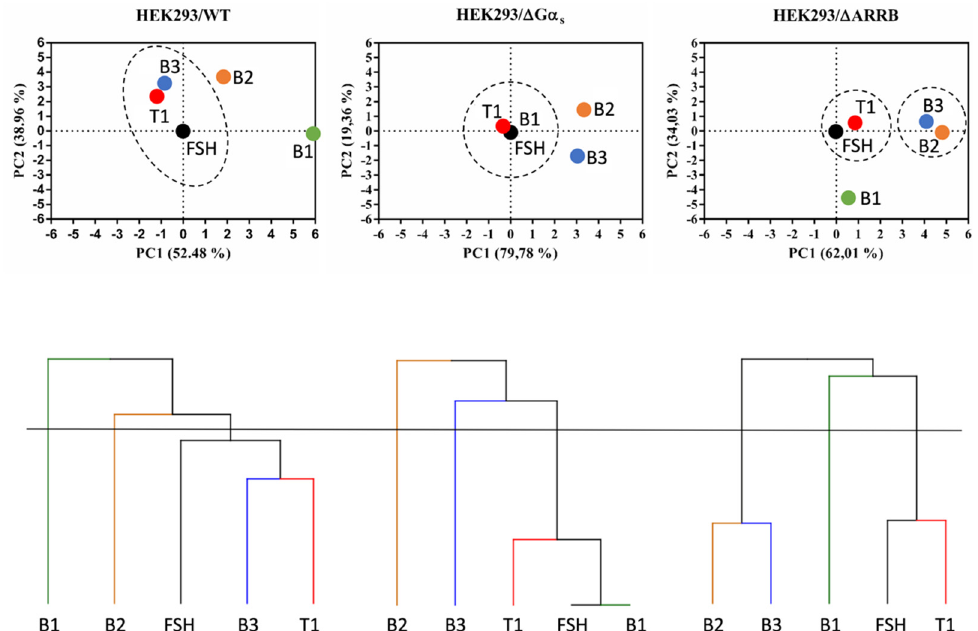
Figure 9. Graphic representation of the biased pharmacological behavior induced by LMW ligands. The biased pharmacological behavior of each LMW (represented in a color code, B1 = green, B2 = orange, B3 = blue and T1 = red) ligand is represented in the shape of an arrow pointing to the direction of bias for each of the pair of read-outs considered in the three cellular contexts. Statistically significant biases (full arrow) as well as observed biases (empty arrow) are shown.